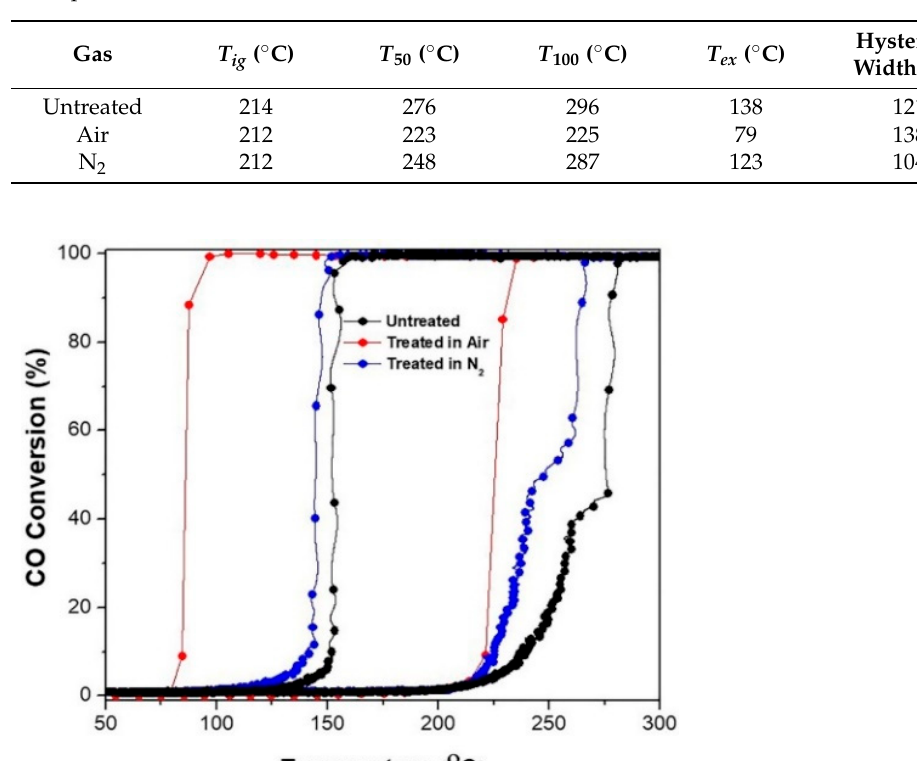
Table 4. Catalytic ignition and extinction profile of Pd/SiO 2 aerogel catalysts annealed in different atmospheres.